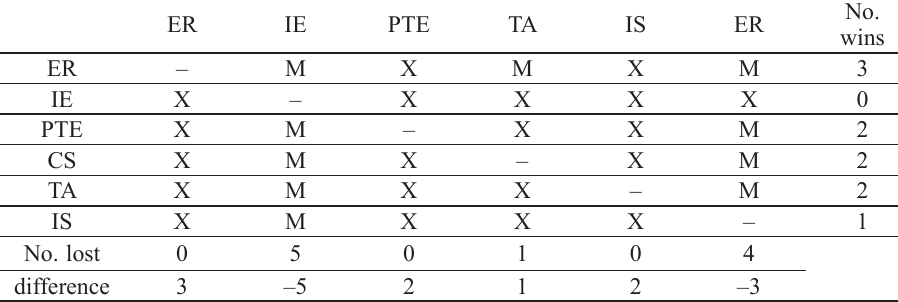
Table 8. The final ranking of EPPs introducing Copeland